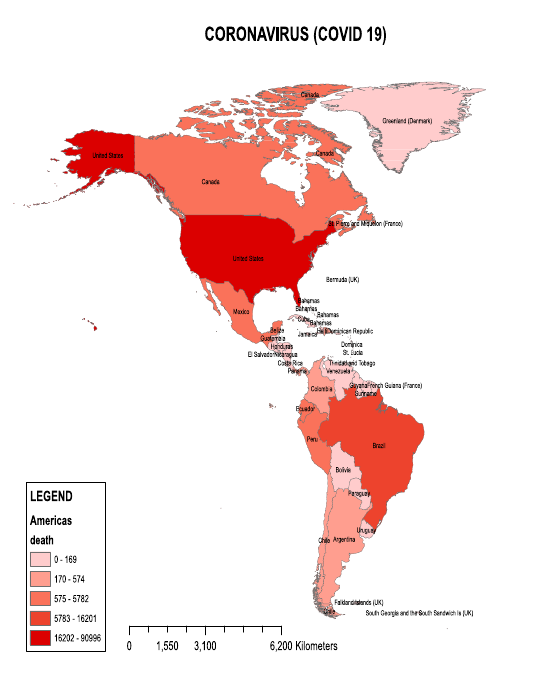
Fig. 4. Spatial distribution of COVID-19 mortality in the